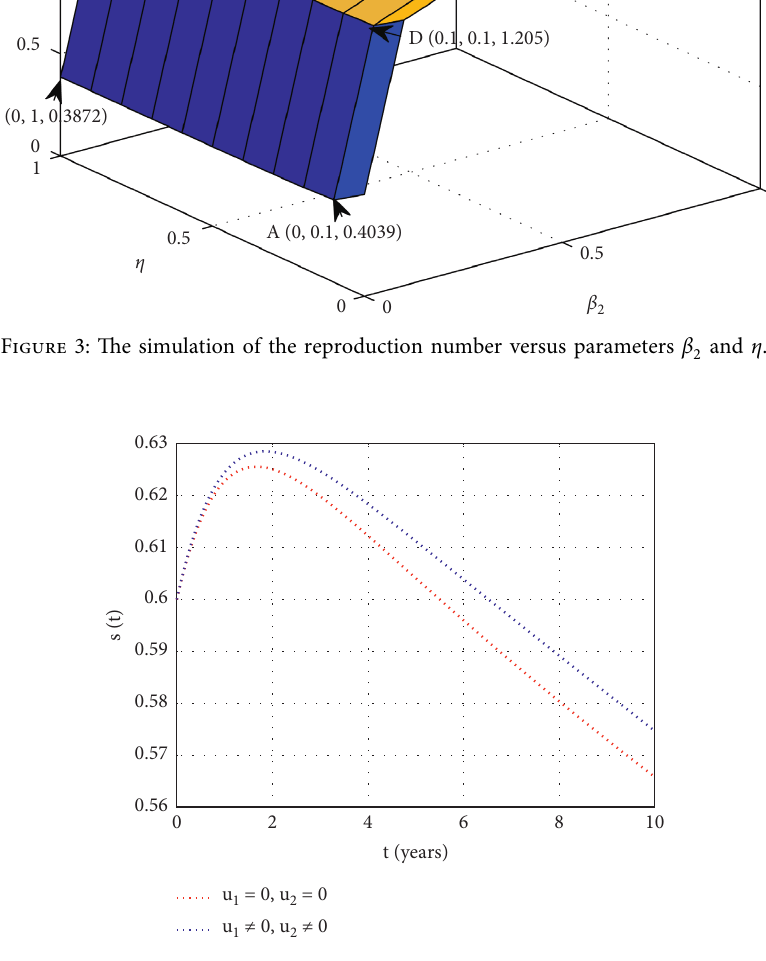
Figure 4: Simulation of susceptible population size without and with